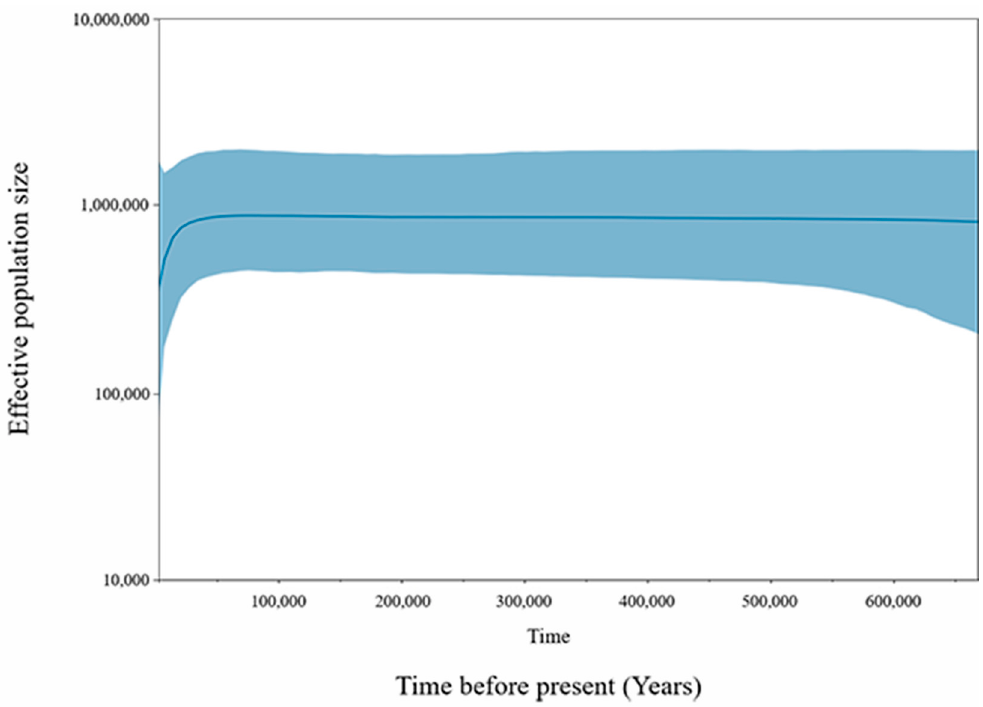
Figure 6. Bayesian Skyline Plots (BSPs) of effective population size over time of T. aduncus in the Andaman Sea of Thailand. The central line represents the mean divergence time value for the log of population size, Y -axis indicates effective population size, X -axis indicates mean time in millions of years to the present, and the blue area represents the standard error.